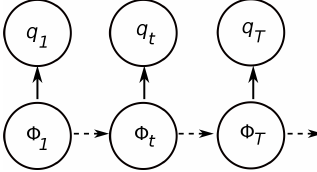
Figure 1. Schematic graph of hidden Markov